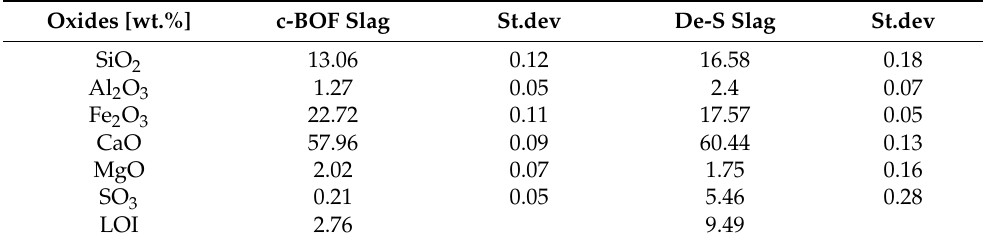
Table 1. Overall chemical composition of slag (wt.%) (X-ray fluorescence). Oxides [wt.%]